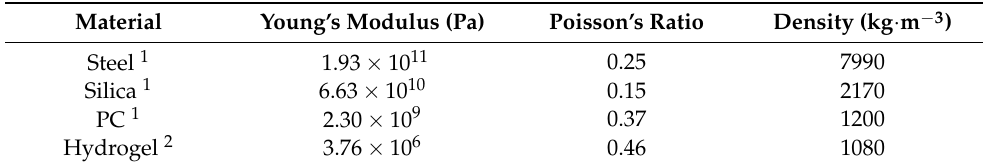
Table 2. Mechanical properties of the probe materials used in the finite element